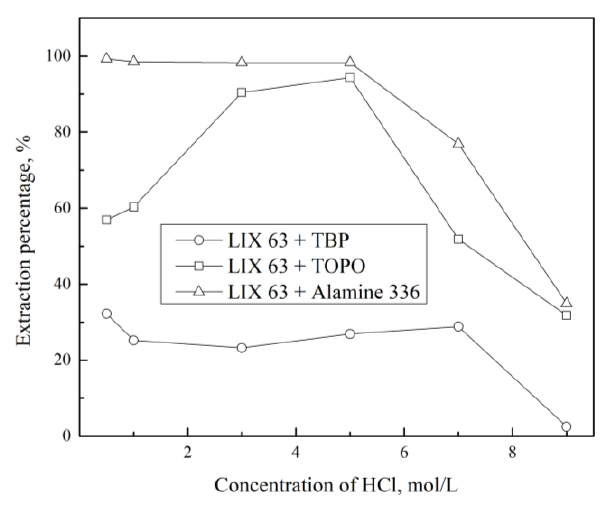
Figure 4. Effect of HCl concentration on extraction of Pd(II). Aqueous: [Pd] = 100 mg/L, [HCl] = 0.5–9 mol/L. Organic: 0.01 mol/L LIX 63 + 0.1 mol/L TBP, 0.01 mol/L LIX 63 + 0.01 mol/L Alamine 336/TOPO. O/A = 1. Diluent: kerosene.